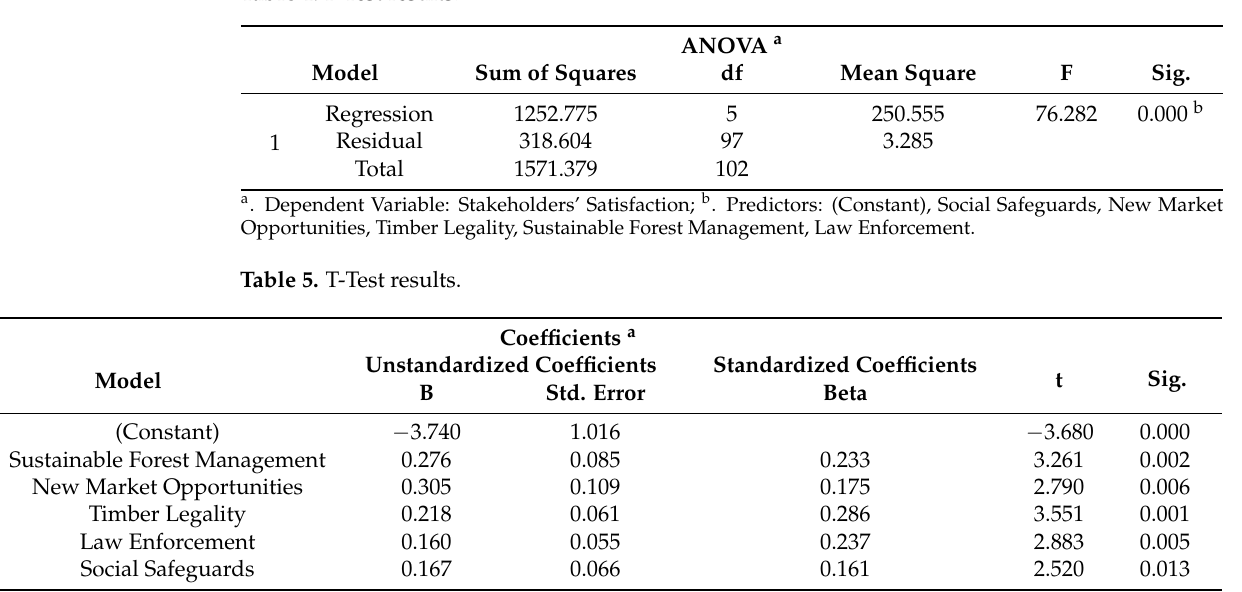
Table 4. F Test results.